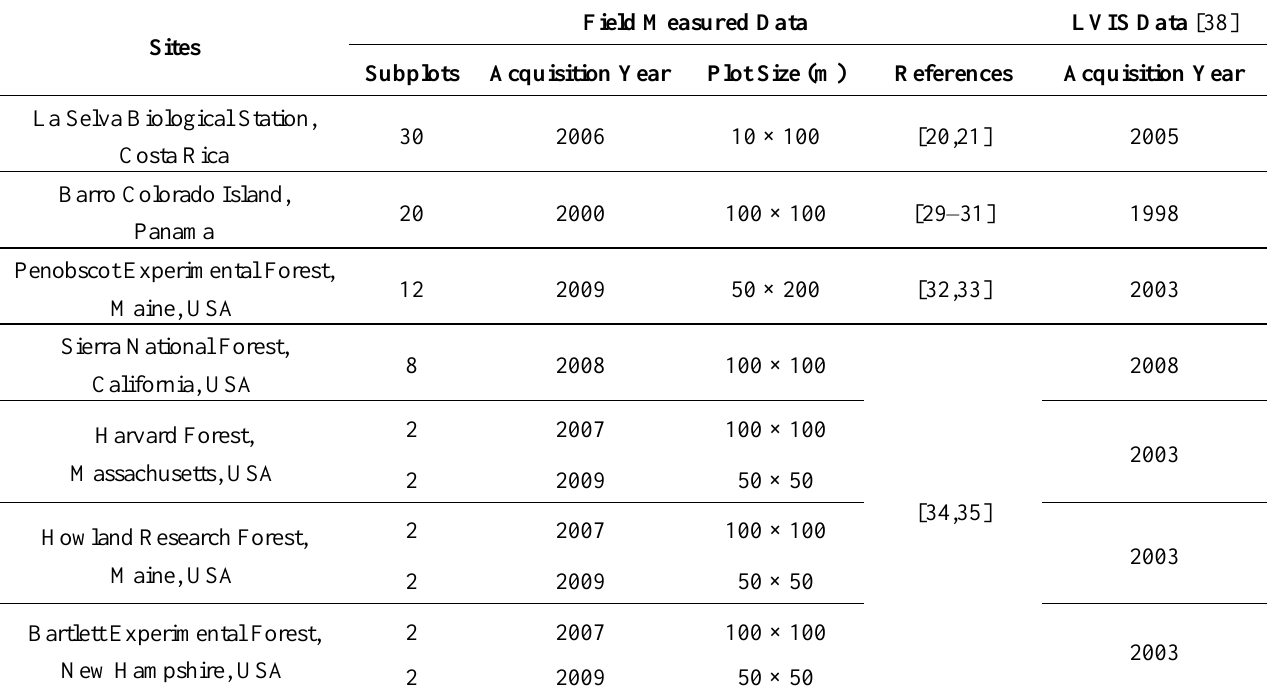
Table 1. Datasets for inter-comparisons between field measured and Laser Vegetation Imaging Sensor (LVIS) waveform derived heights. There are 82 measurement plots spanning seven field sites in this study.